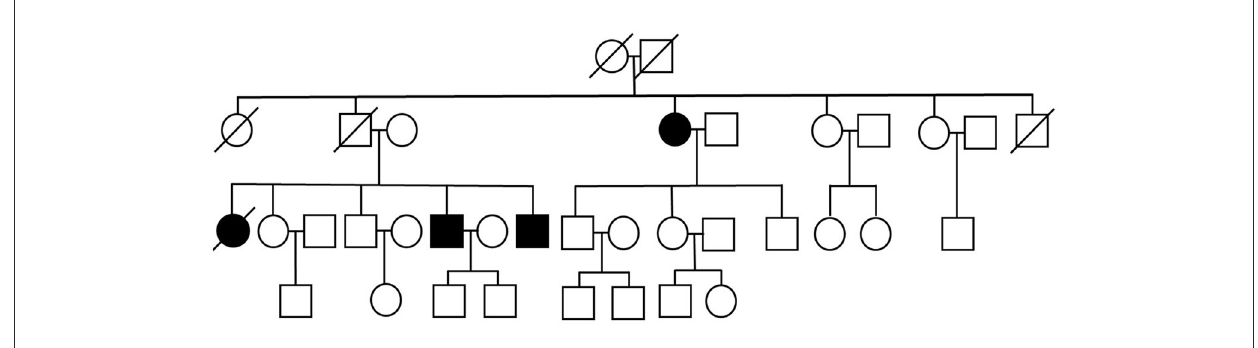
FIGURE1 Pedigree of the studied polish